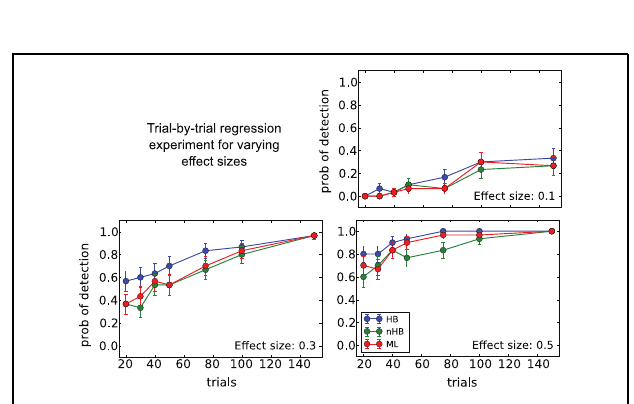
FIGURE 8 | Trial-by-trial covariate experiment. Probability of detecting a trial-by-trial effect on drift-rate (y-axis) with effect-sizes 0.1 (top left plot) , 0.3 (bottom left plot) and 0.5 (bottom right plot) for different estimation methods (color coded; HB, Hierarchical Bayes; nHB, non-hierarchical Bayes; ML, maximum likelihood). While there is only a modest increase in detection rate with the smallest effect size, HB provides an increase in detection rate of up to 20% with larger effect sizes and fewer